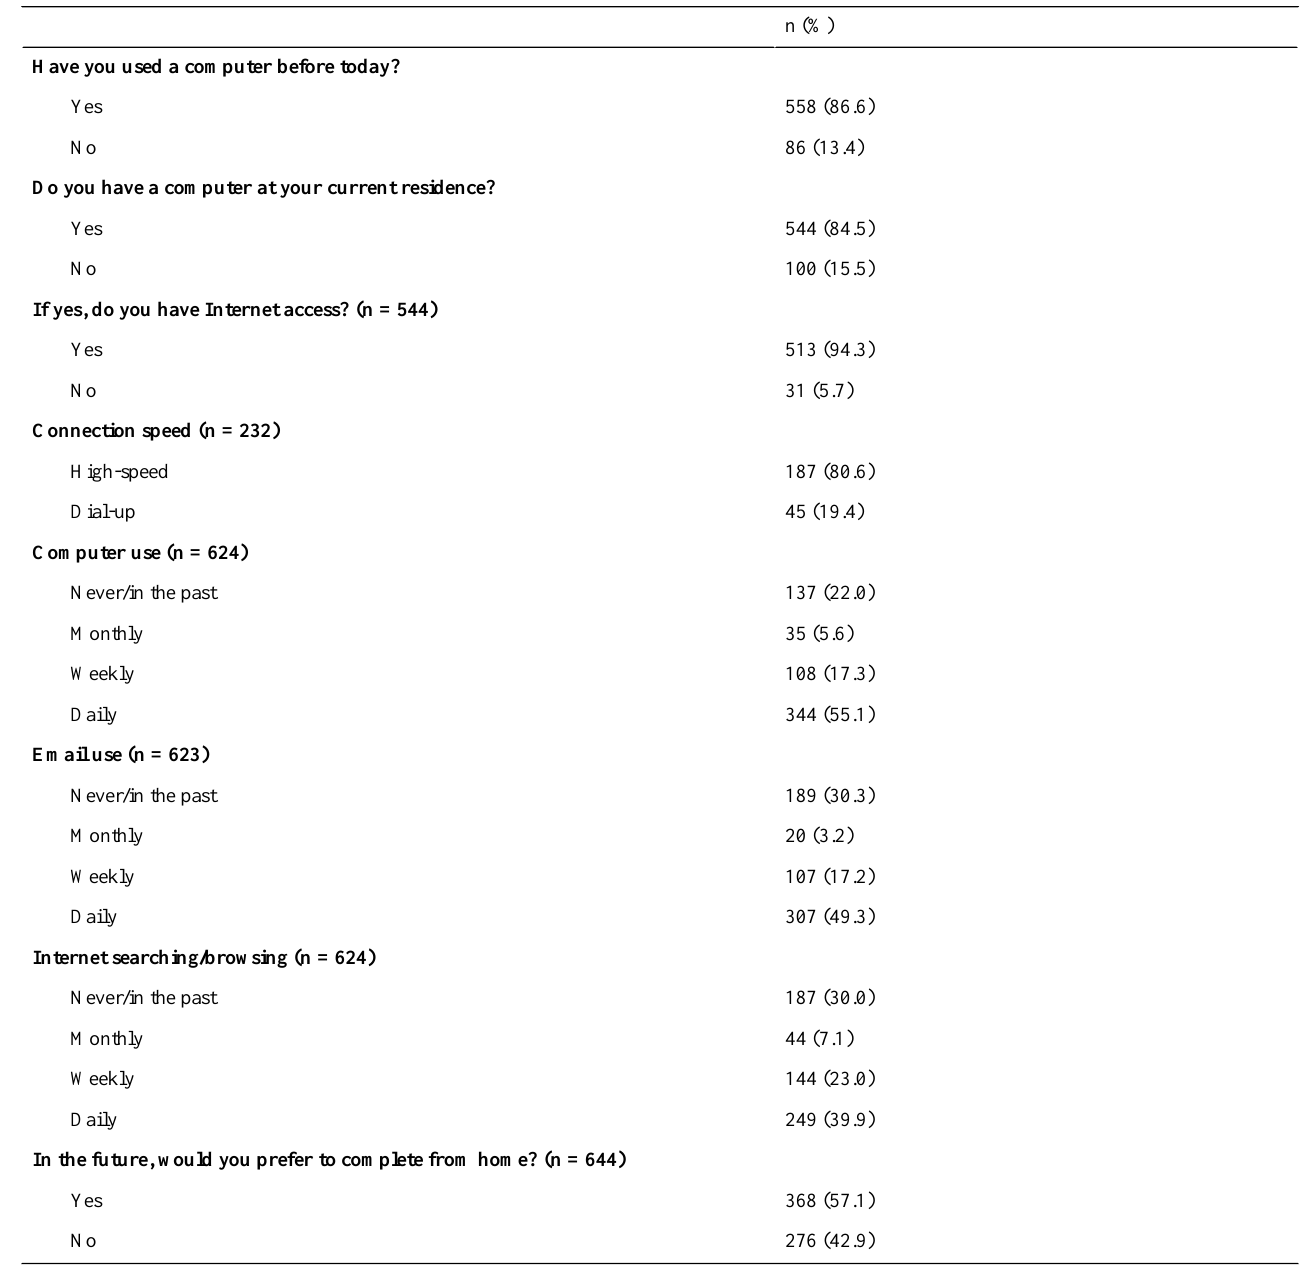
Table 2. Computer use questionnaire and responses in 644 subjects